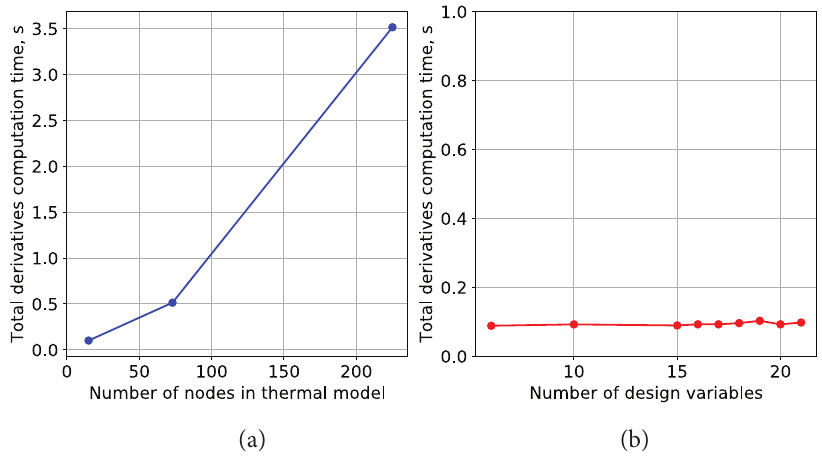
Figure 7. Time for computing total derivatives of objective and constraints with respect to design variables for (a) varying model fi delity and (b) varying number of design variables